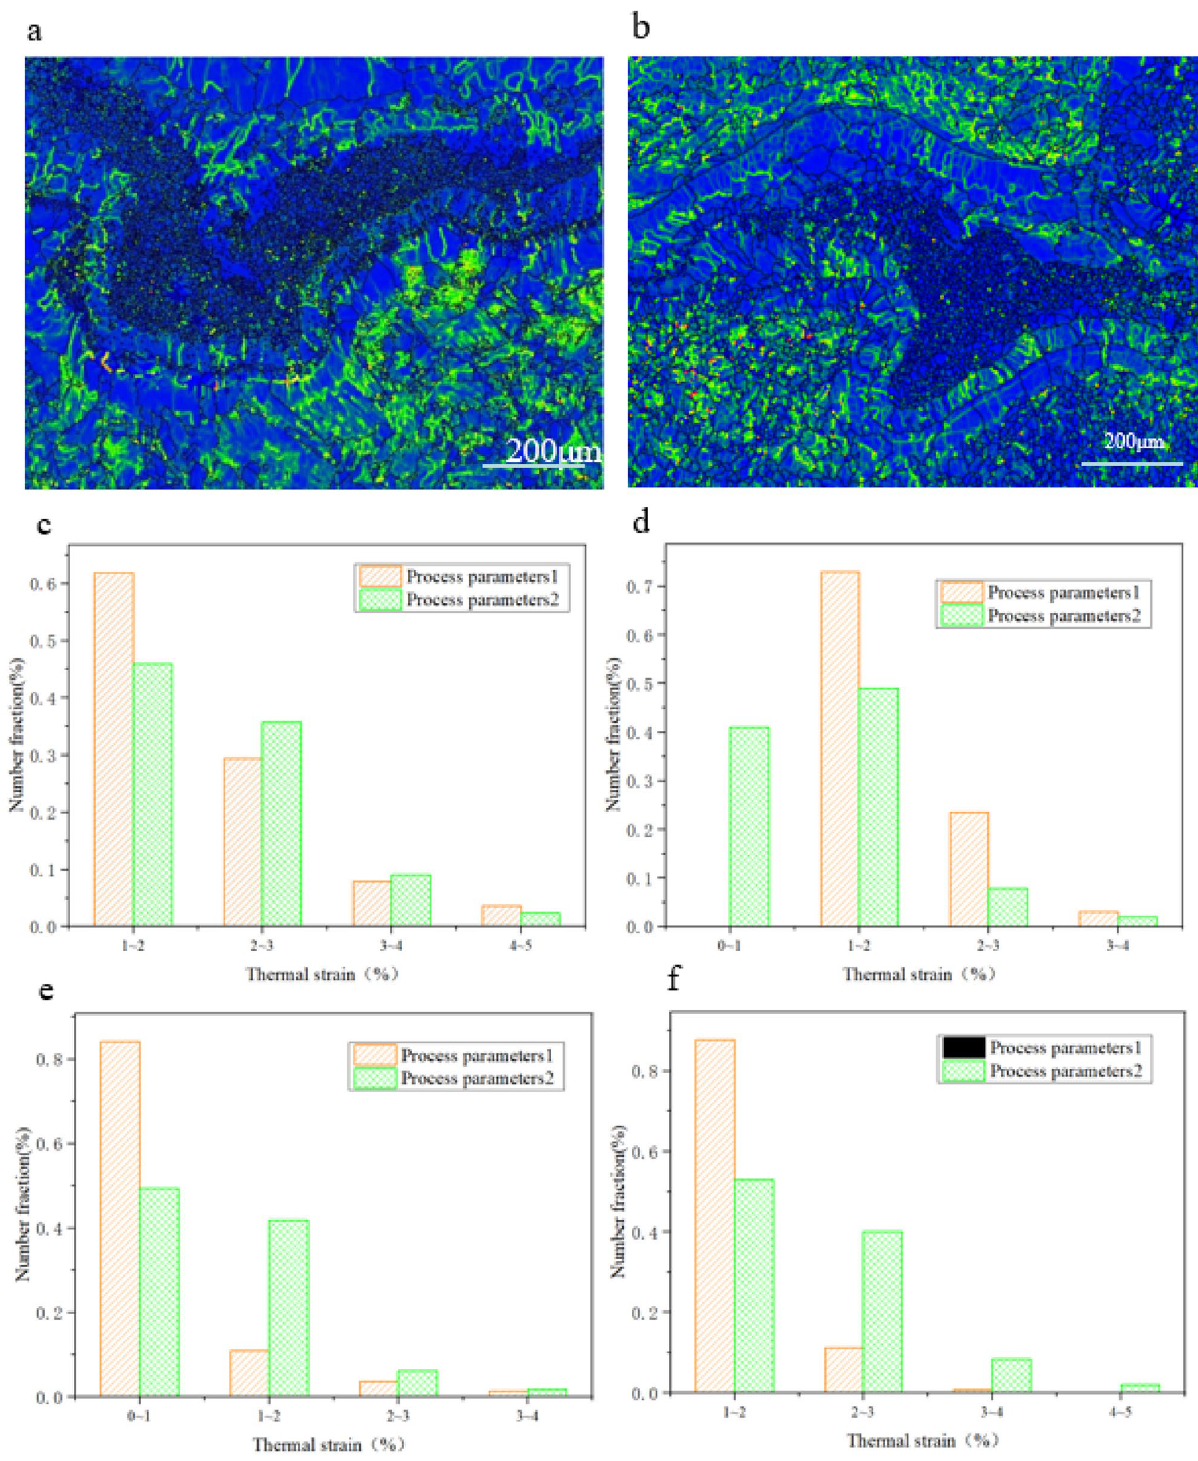
Figure 10. Plastic strain change of different phases: ( a ) Grain boundary diagram of the first parameter ( b ) Grain boundary diagram of the second parameter ( c ) plastic strain of phase Fe ( d ) plastic strain of phase FeTi ( e ) plastic strain of phase Fe 2 Ti ( f ) plastic strain of phase